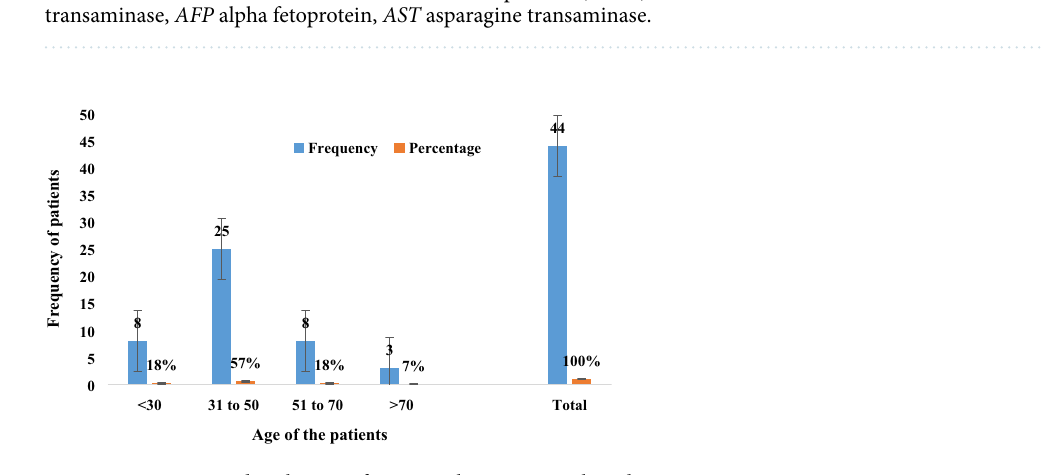
Figure 1. Frequency distribution of HCV cirrhotic patients based on